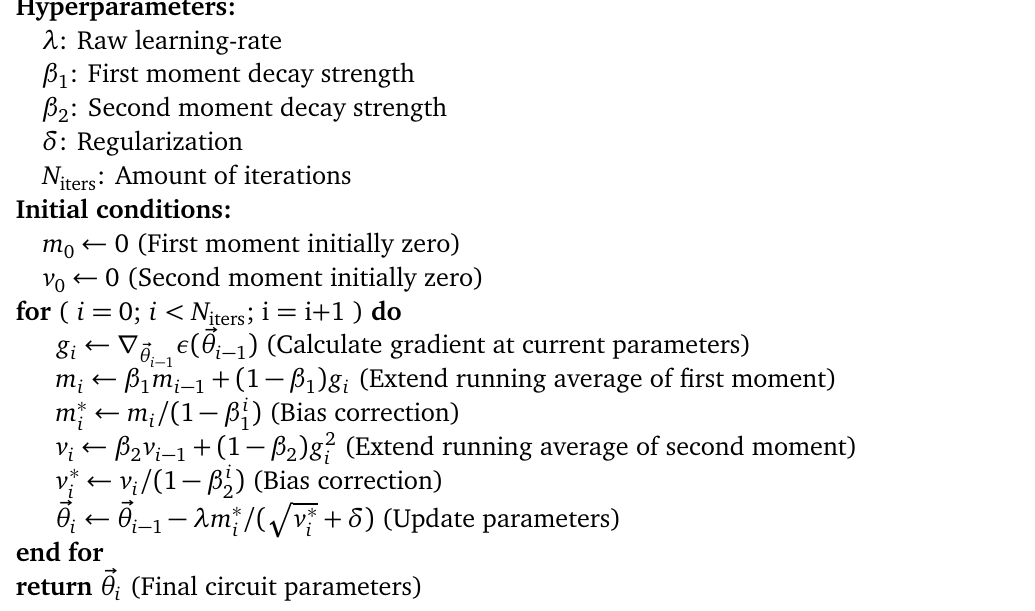
Algorithm 1 Vanilla Adam [ 52 ] . This gradient-descent optimizer updates the circuit parame- ⃗θ ⃗θ ) ters to minimize the infidelity ε ( , by taking into account exponentially decaying running averages of the first moment m and second moment v of the infidelity gradient g for each parameter separately. Instead of choosing the parameter updates to be proportional to g , as in vanilla gradient descent, here it is proportional to a memory of the previous gradients m